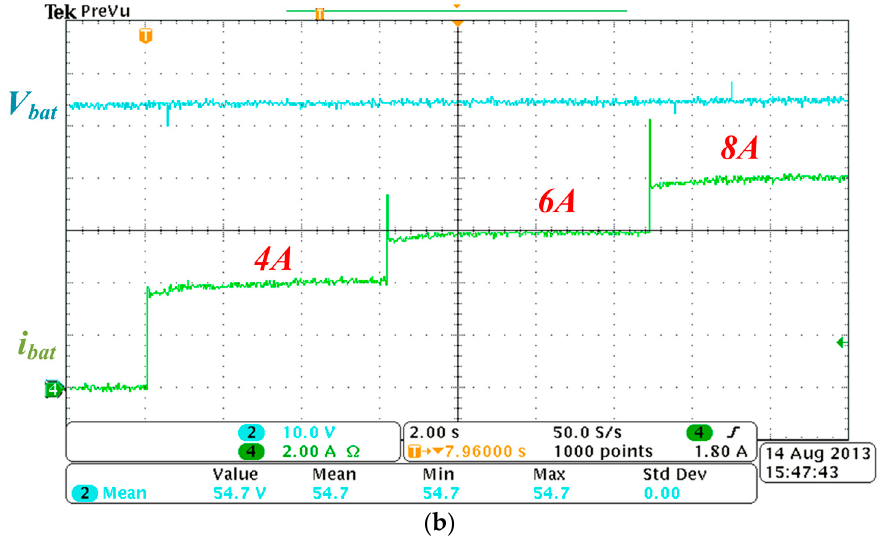
Figure 9. Transient waveforms. ( a ) Waveforms when the modulation switches; ( b ) Waveforms when charging current changes.